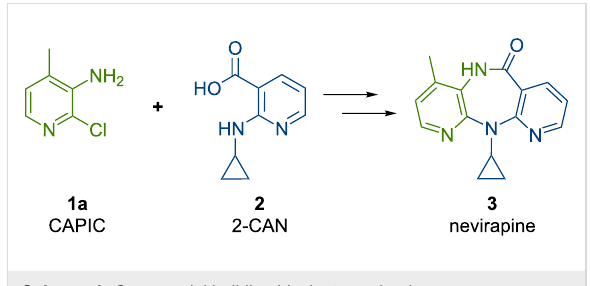
Scheme 1: Commercial building blocks to nevirapine.